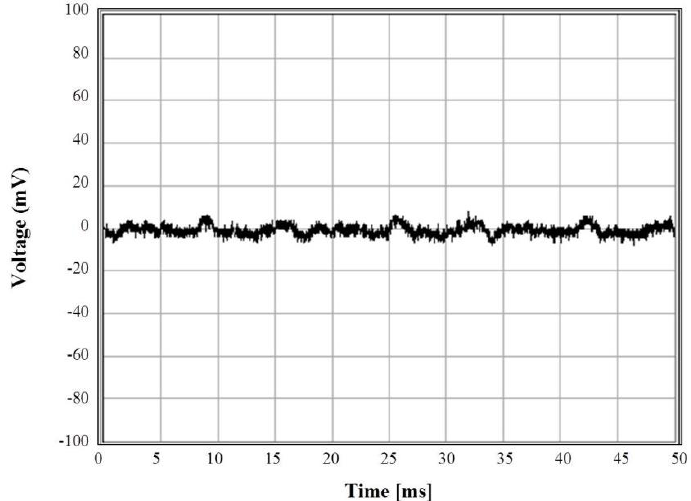
Figure 5. The neural spikes of neuroblastoma cells cultured for 7